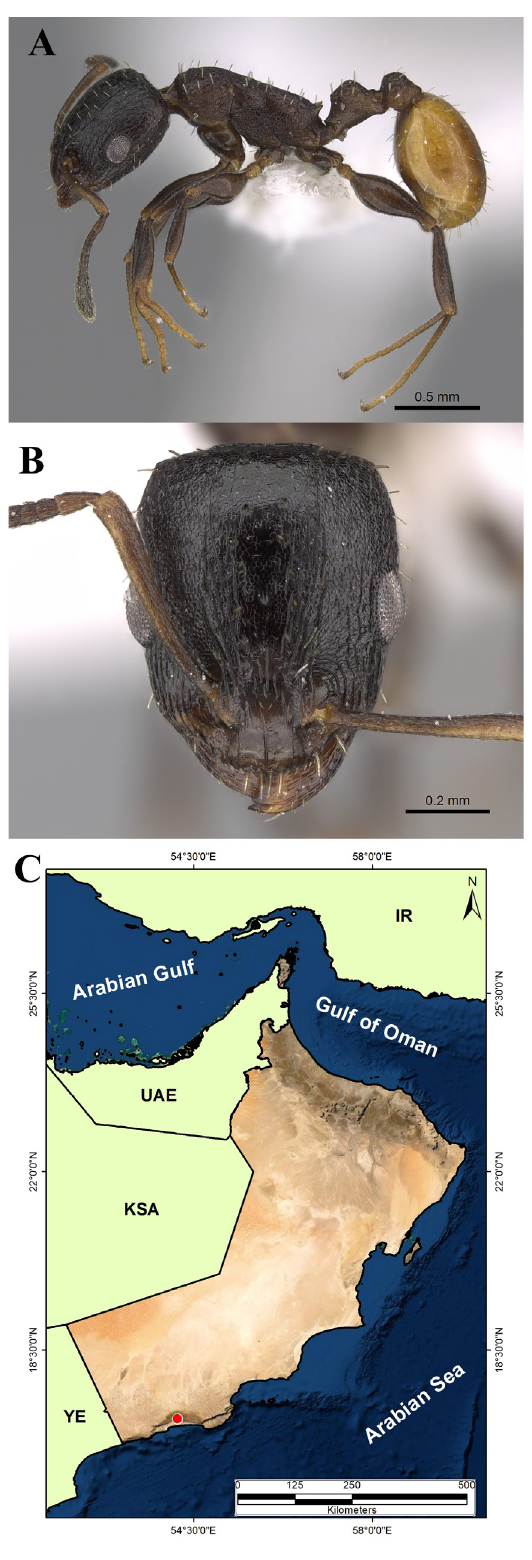
Fig. 44. Nesomyrmex micheleae Sharaf, 2020, paratype, worker (CASENT0922872, AntWeb.org (Michele Esposito)) A . Body in profile. B . Head in full-face view. C . Distribution